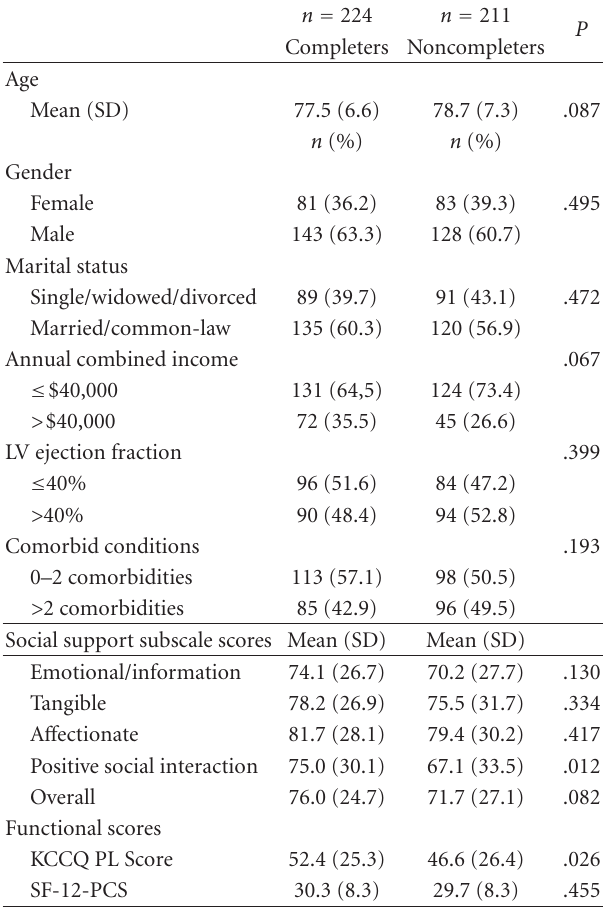
Table 1: Comparison of baseline characteristics of participants who completed 12-month questionnaires to those who were lost to followup or